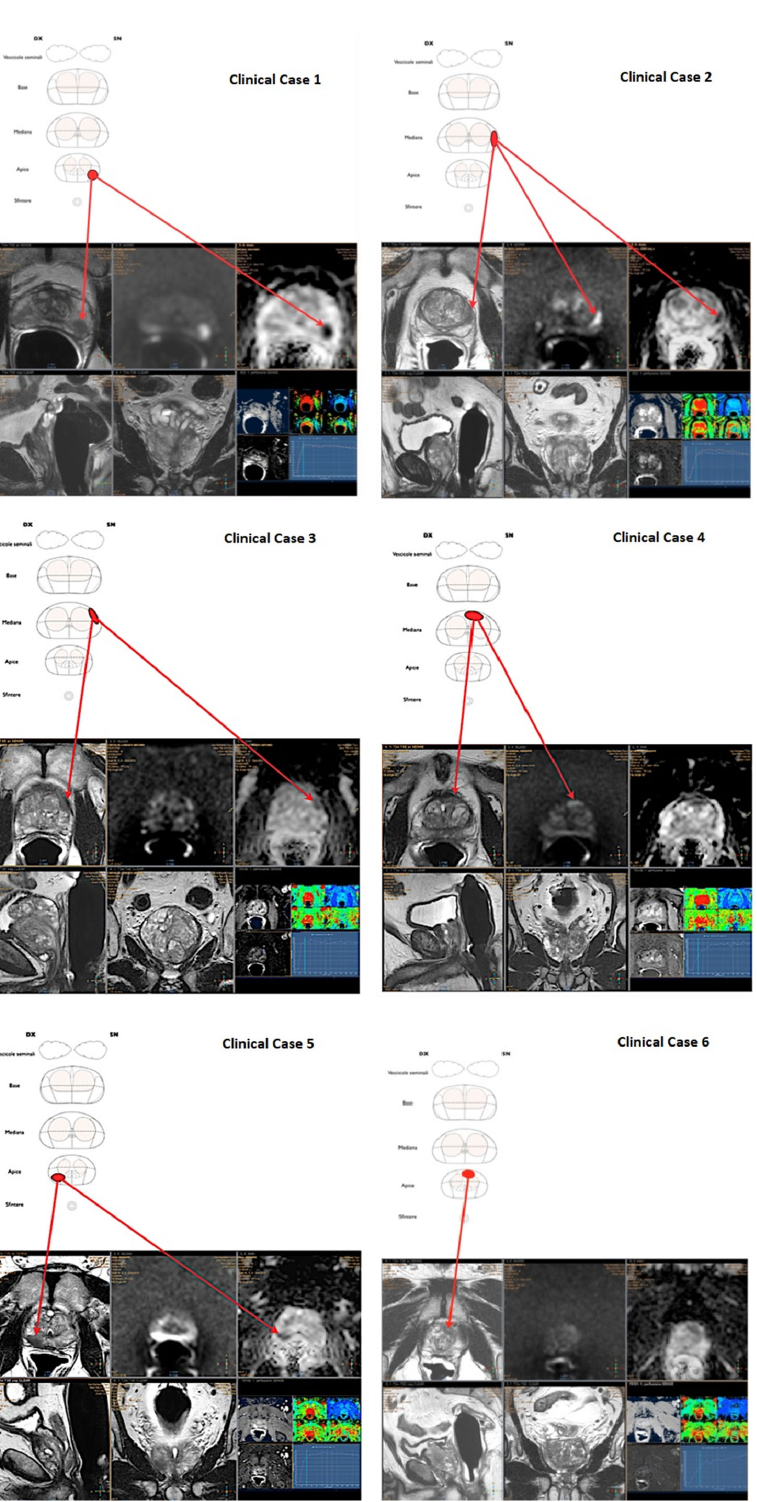
Figure 1. First set of six mpMRI images used for urologists’ interpretation skills assessment.